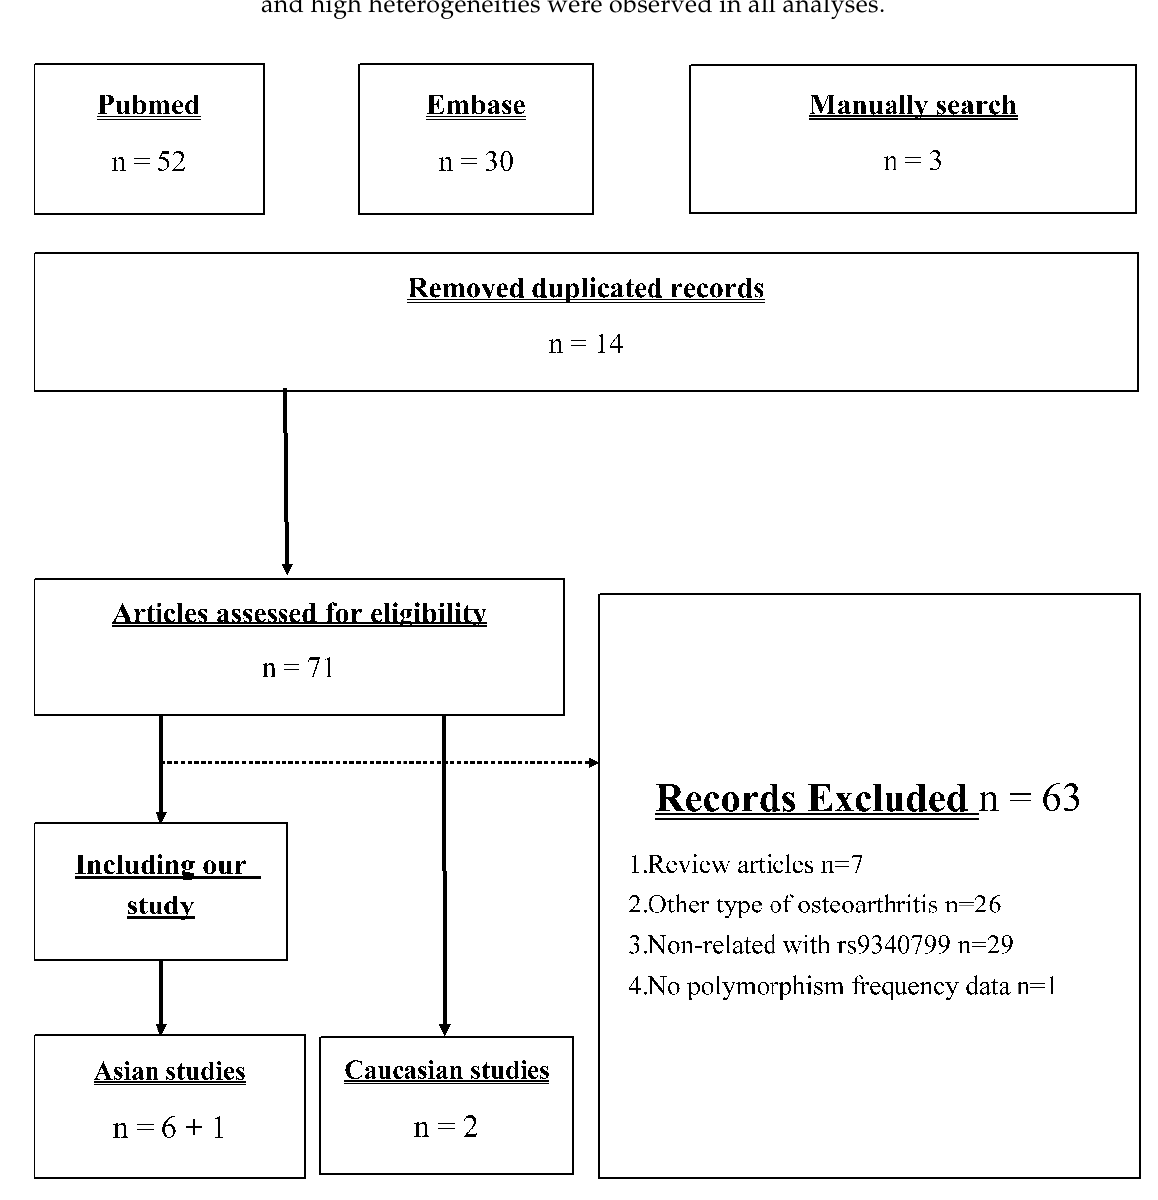
Figure 1. Flow diagram of the identification process for eligible studies.